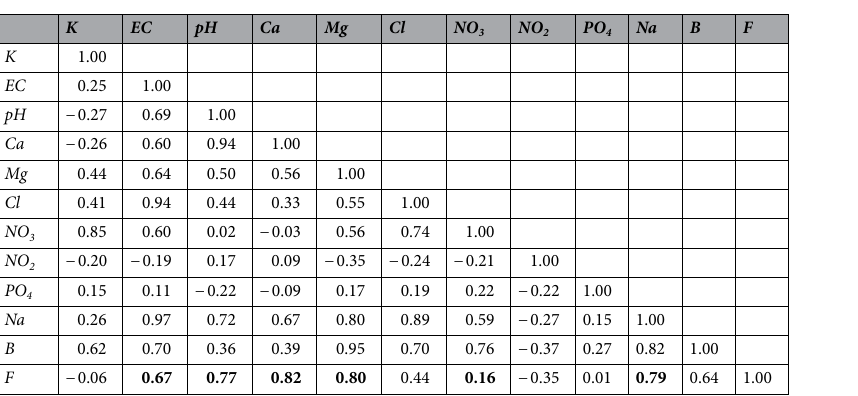
Table 8. Correlation of physico-chemical constituent of